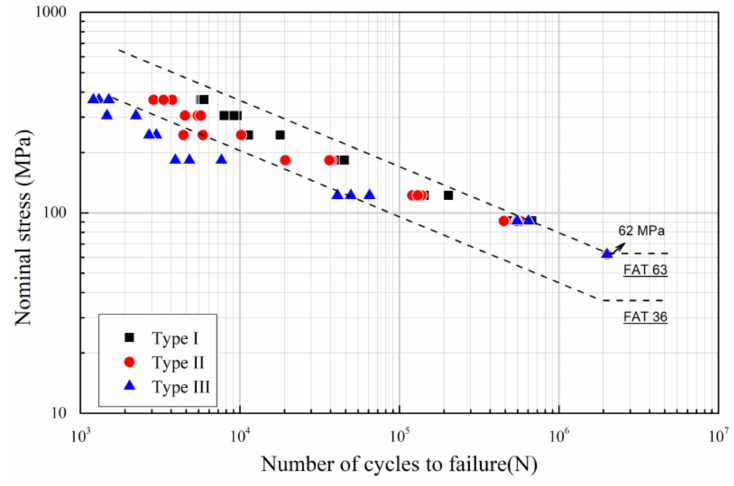
Figure 12. S – N curves according to weld types (FAT: Fatigue